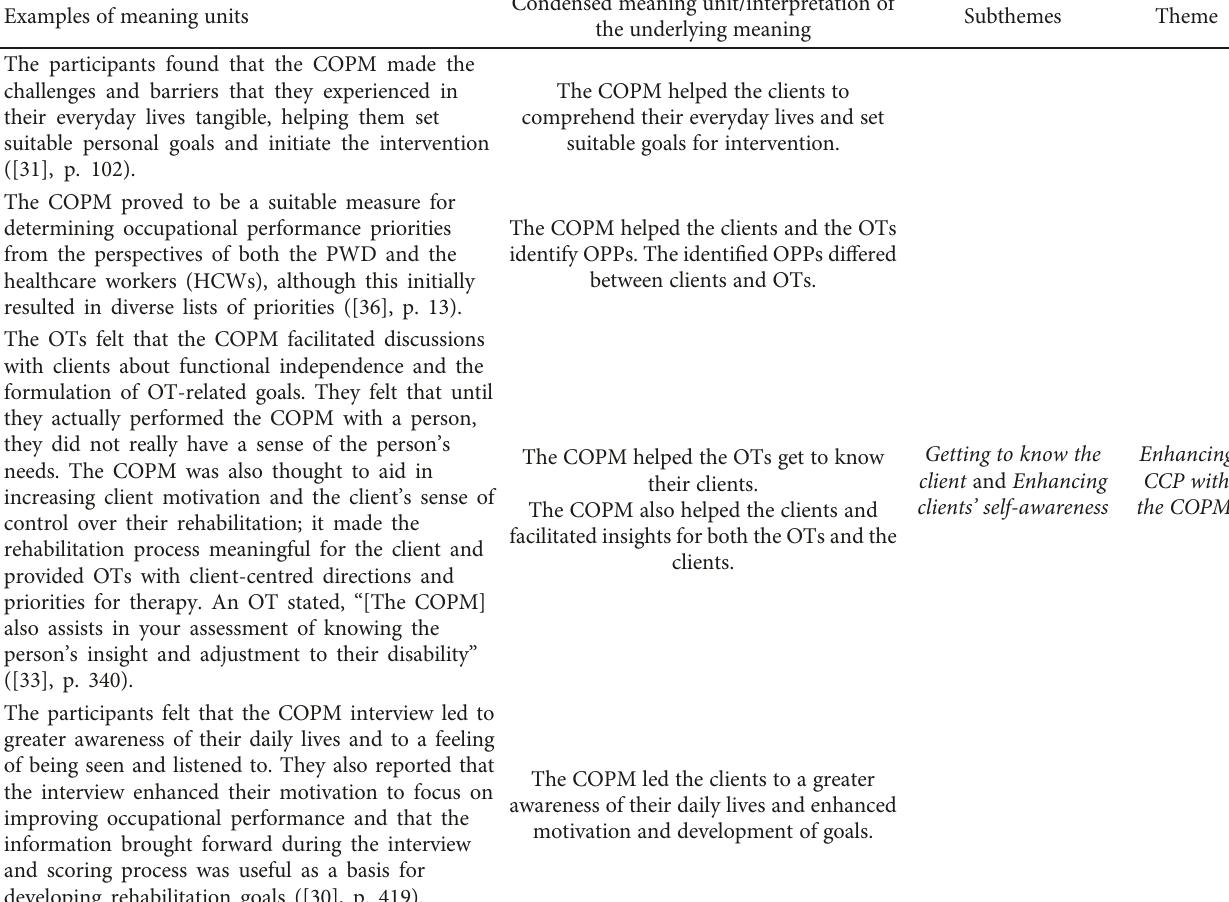
Table 2: Meaning units, condensed meaning units, subthemes, and themes from the content analysis. Examples of meaning